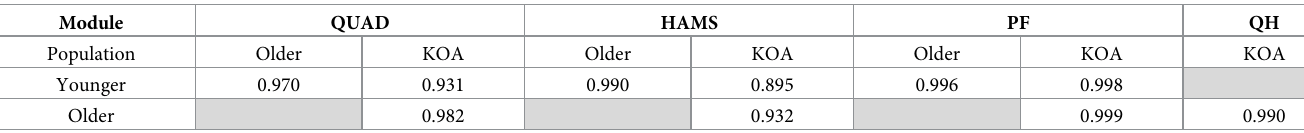
Although the total number of modules differed between subjects across the populations, four common modules were identified between at least two participants within two or more popu- lations (Table 2; Figs 3–5): 1) the quadriceps (QUAD) module characterized by high muscle weightings for the rectus femoris, vastus medialis, and vastus lateralis, 2) the hamstrings (HAMS) module characterized by high muscle weightings for the medial hamstrings and Table 2. Common module pearson correlation coefficients between